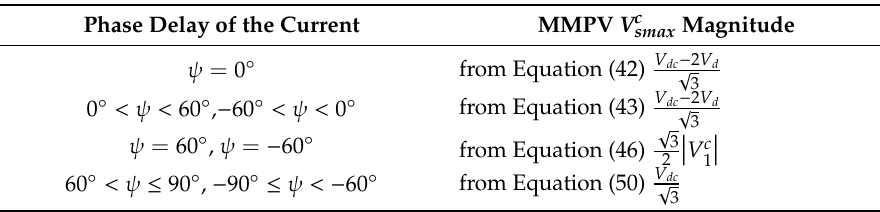
Figure 17. Distorted voltage regions and voltage vectors according to the current phase ψ ; ( a ) ψ = 0 ◦ ; ( b ) 0 ◦ < ψ < 60 ◦ ; ( c ) ψ = 60 ◦ ; ( d ) 60 ◦ < ψ ≤ 90 ◦ . Table 2. The compensated MMPV V c smax when the proposed DTCS applied.